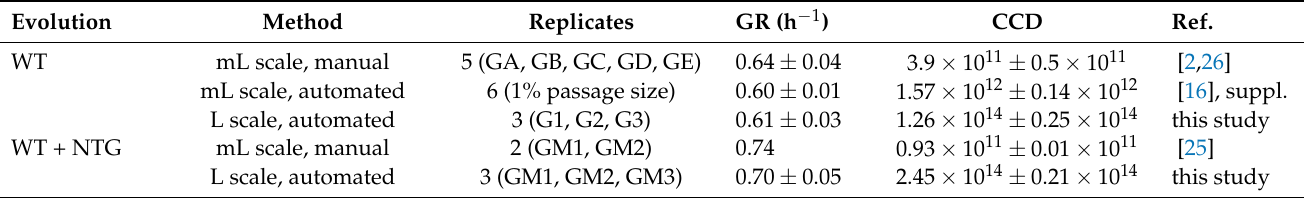
Table 1. Comparison of the key results of the ALE experiments performed in this study compared to the results from the